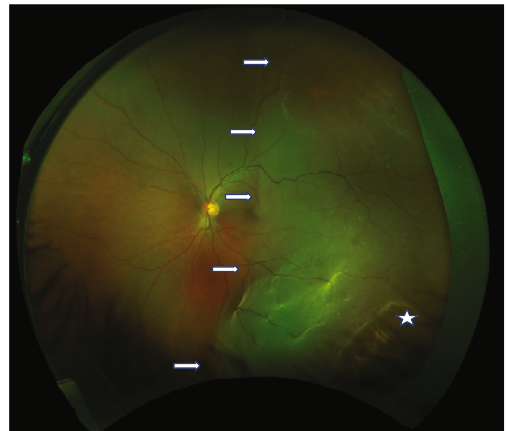
Figure 1: Wide- fi eld fundus photo of left eye showing the temporal retinal detachment involving partially the macula (arrow) and lattice degeneration with retinal hole (Asterisk).